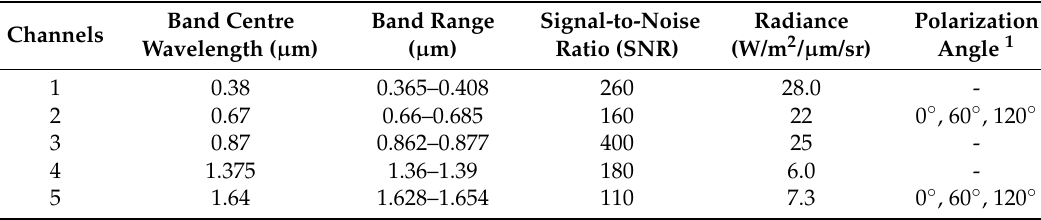
Table 1. Instrument configuration for the Cloud and Aerosol Polarimetric Imager